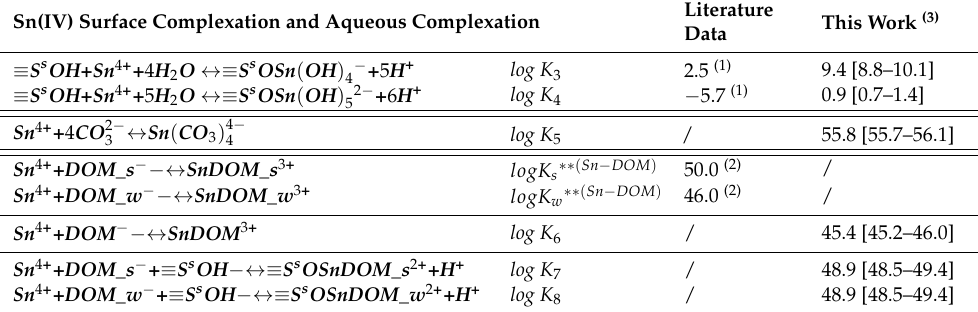
Table 5. Sn(IV) surface complexation and aqueous complexations reactions and their corresponding constants implemented in the sorption